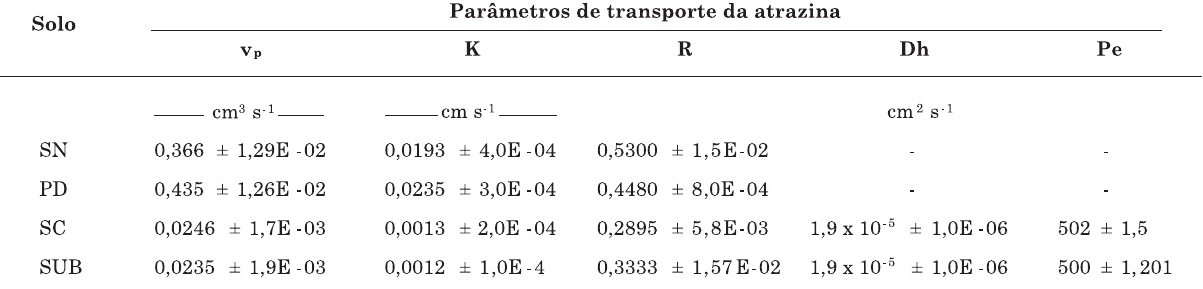
PD.Quadro 2. Parâmetros de transporte da atrazina: velocidade nos poros (v fator de retardamento (R), coeficiente de dispersão (Dh) e número de Peclet (Pe)